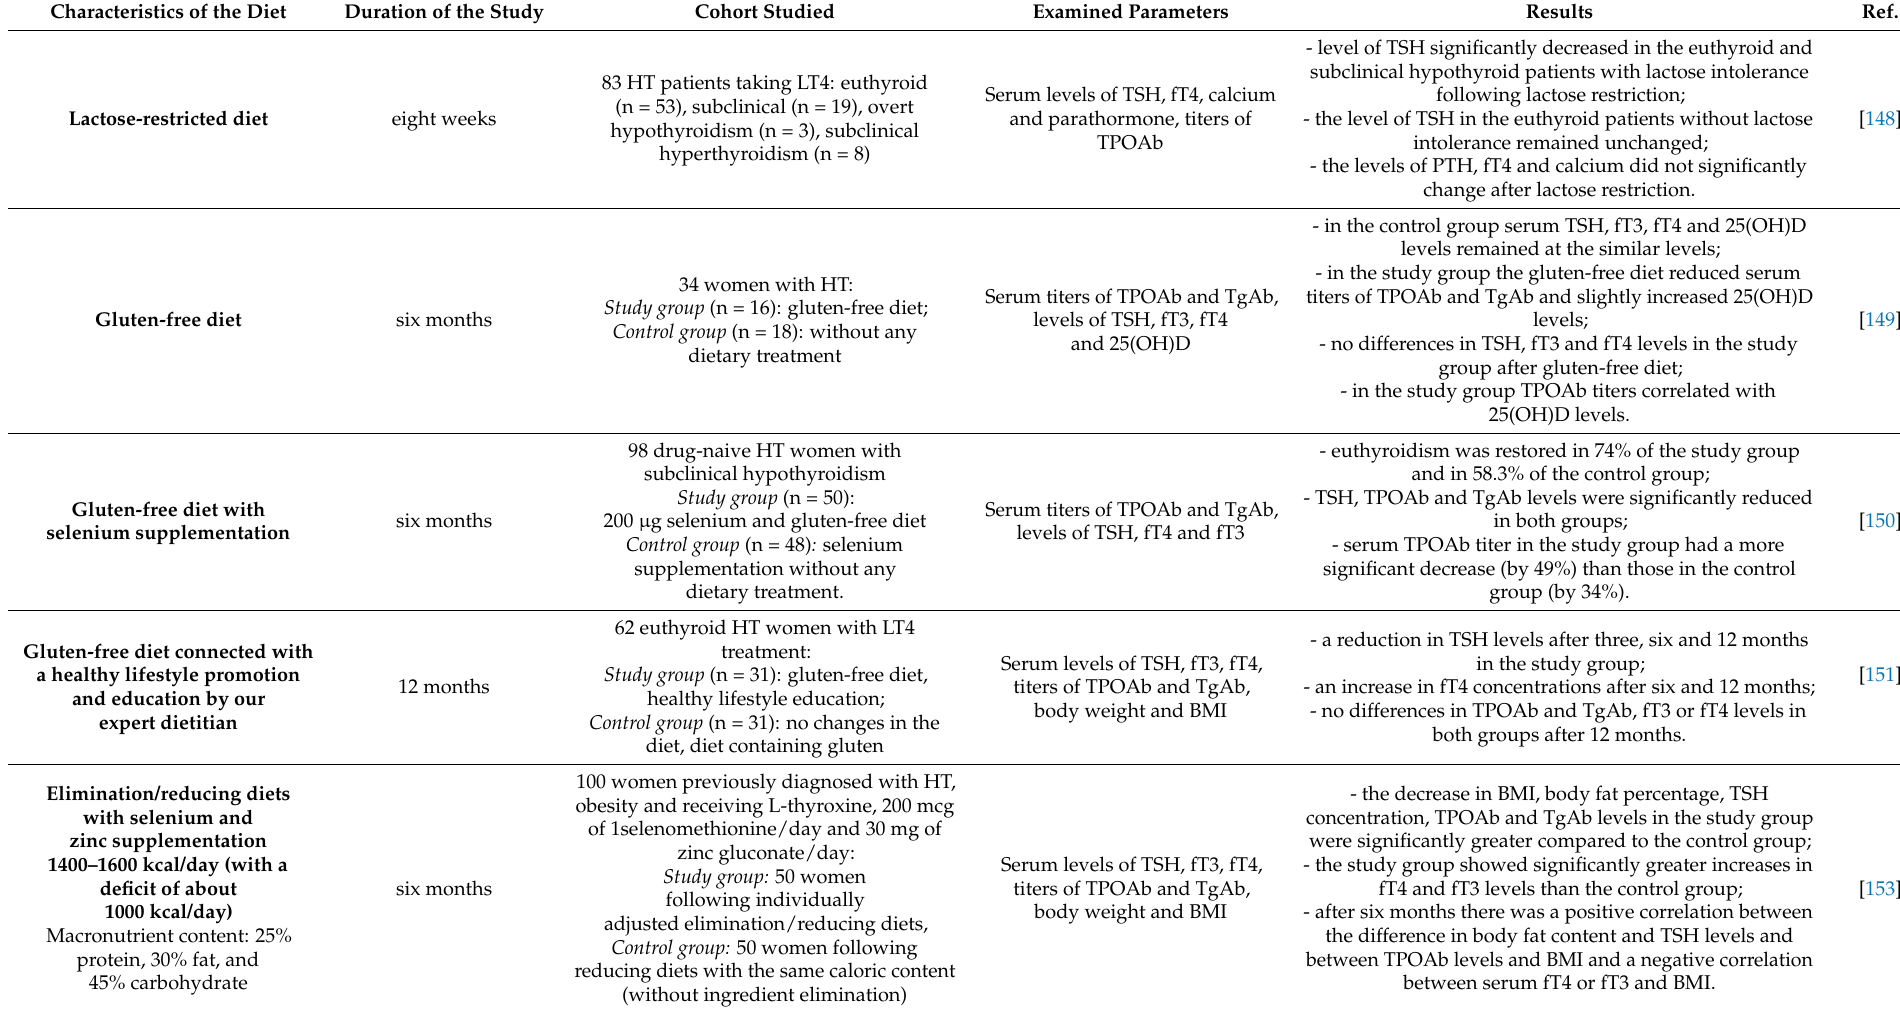
Table 3. The summary of dietary interventional studies impact on the treatment and management of